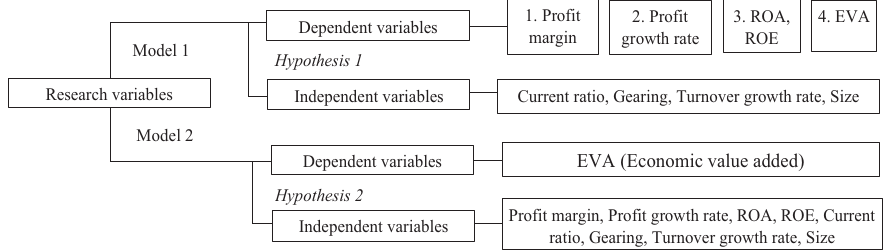
Figure 2. The framework of methodology (source: elaborated by the